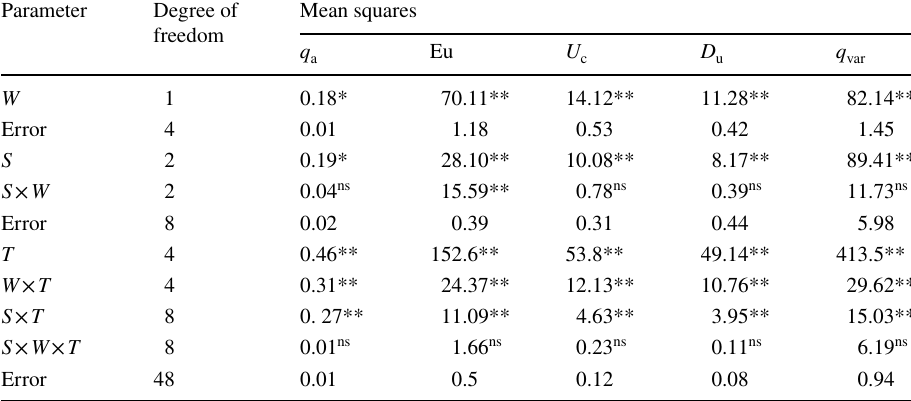
Table 5 Analysis of variance for the